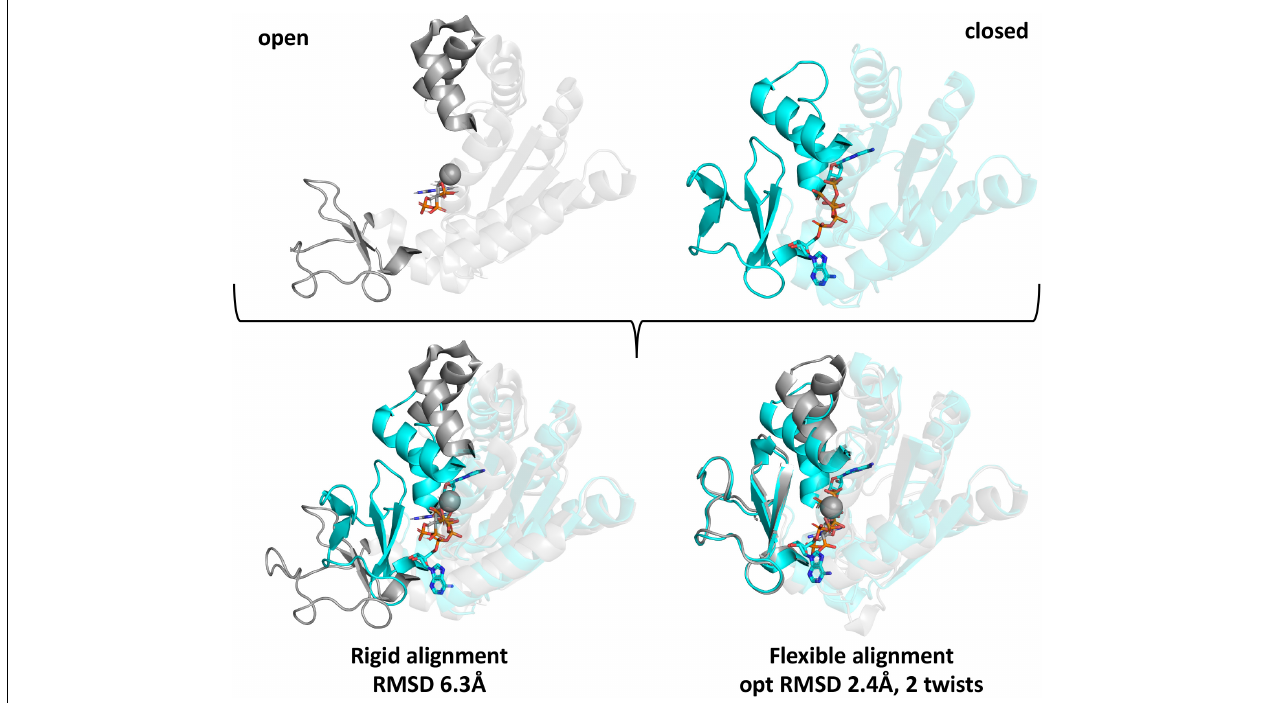
FIGURE 5 | Comparison of rigid and flexible structural alignments of open and closed forms of the E. coli Adk protein using Pymol and FATCAT. The open form of the Adk protein crystal structure is shown in gray (PDB ID: 6f7u chain A) and the closed form is cyan (PDB ID: 1ake chain A). Ligands are shown as sticks and spheres are metal ions from the crystal structures. Regions of the protein that adopt significantly variable conformations are in bold colors and the remainder of the protein is transparent. Structural alignments between the open and closed forms using rigid or flexible alignment methods and their corresponding RMSD-values between alpha carbon atoms are indicated beneath the aligned